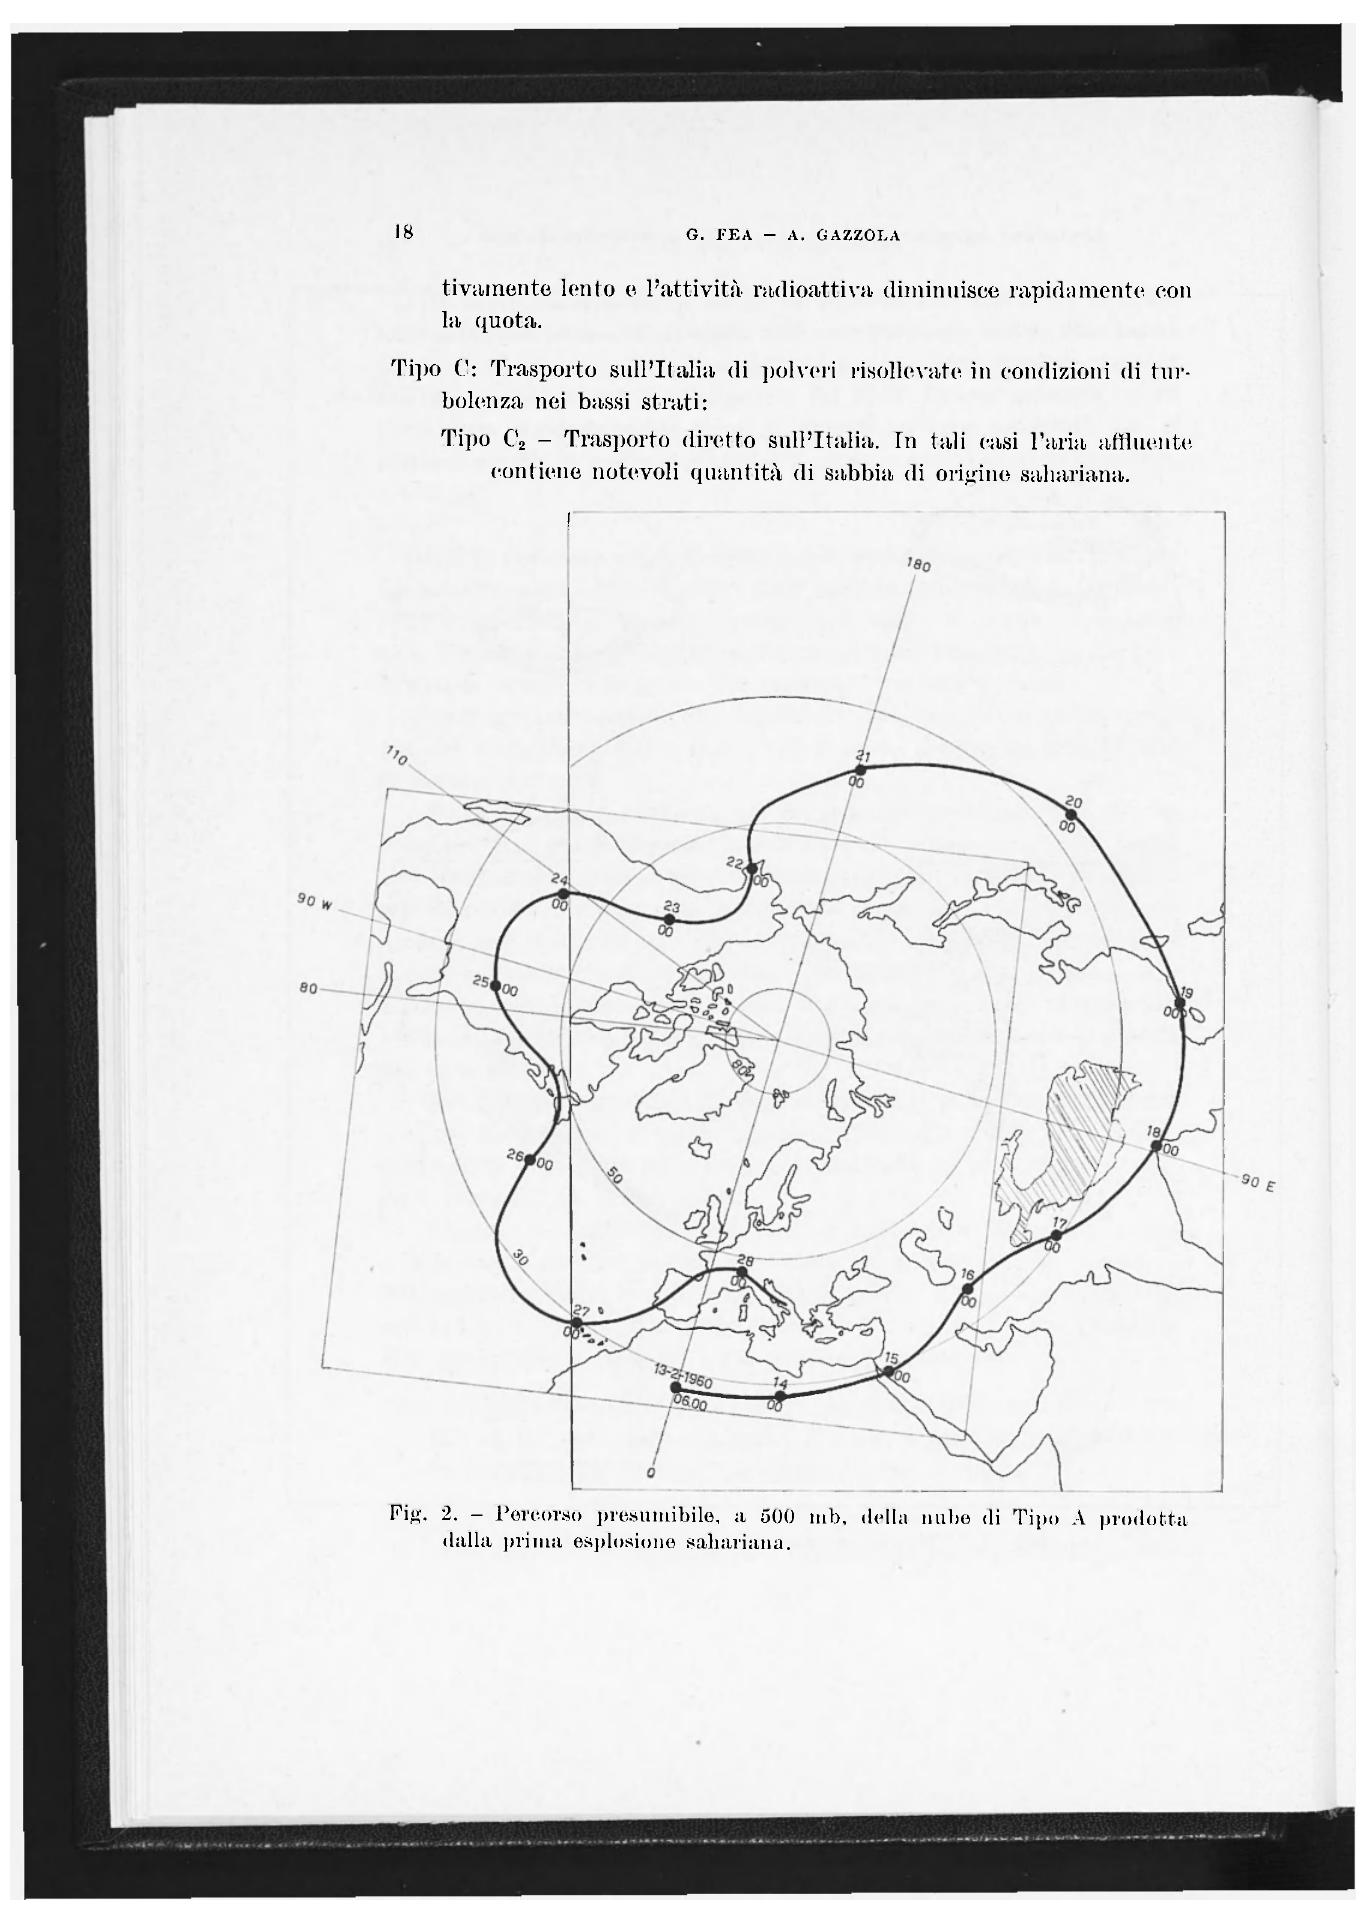
Fig. 2. - Percorso presumibile, a 500 mb, della nube (li Tipo A prodotta dalla prima esplosione